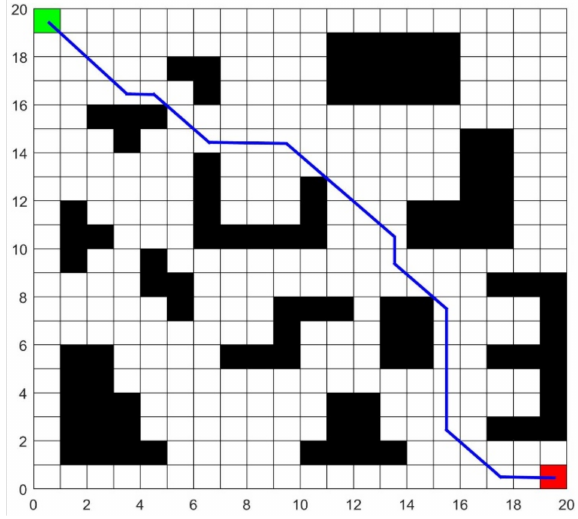
Figure 6. Raster method for modelling the airspace environment (The green and red squares represent the start and end of the discretized route).